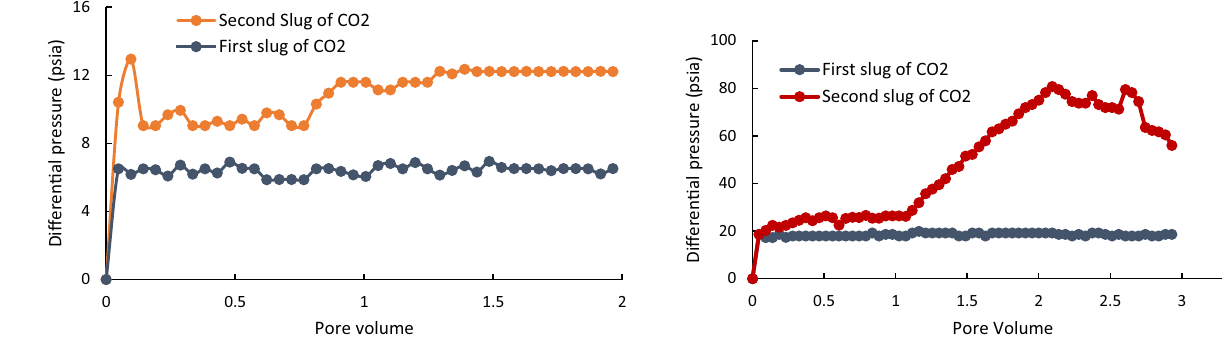
Fig. 3 Performance of injected CO Fig. 5 Performance of injected CO 2 slug before and after blended 2 slug before and after blended surfactant solution of 0.2%AOS + 0.2%TX100 surfactant solution of 0.6%AOS +